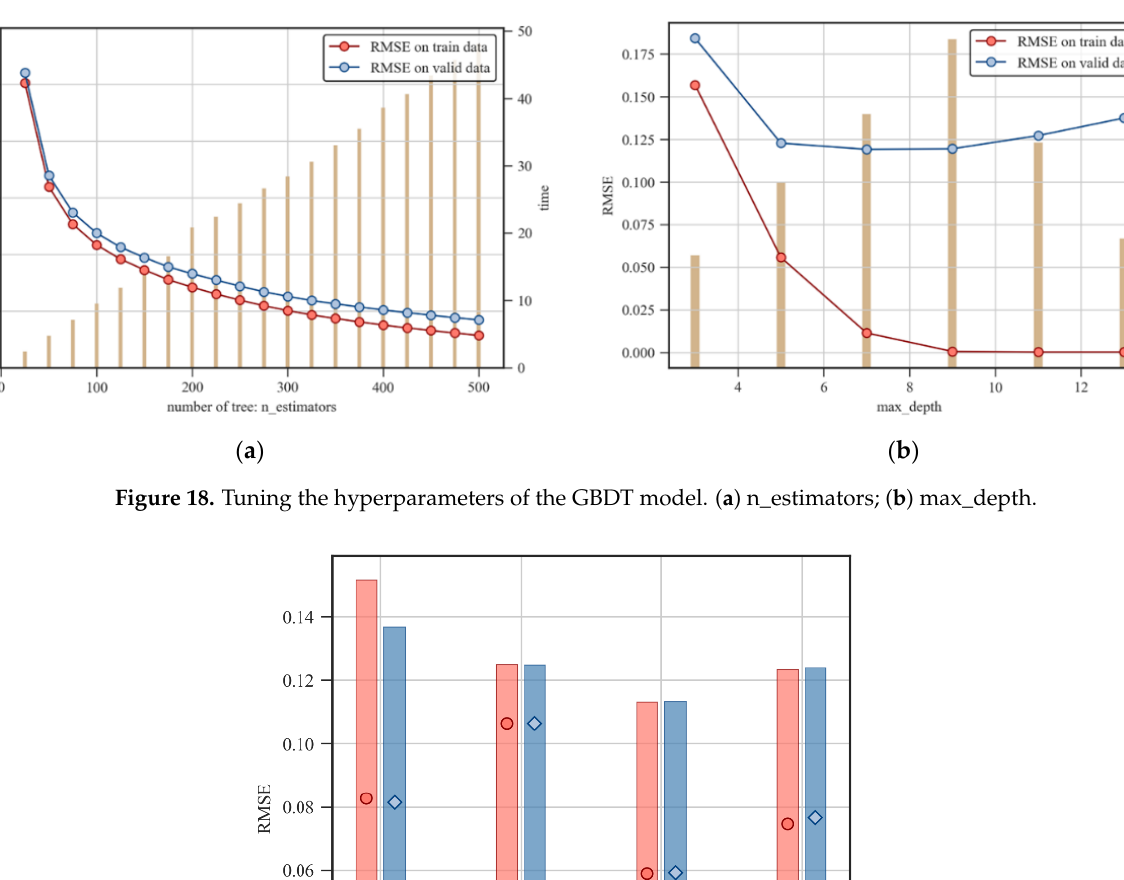
Figure 18. Tuning the hyperparameters of the GBDT model. ( a ) n_estimators; ( b ) max_depth.